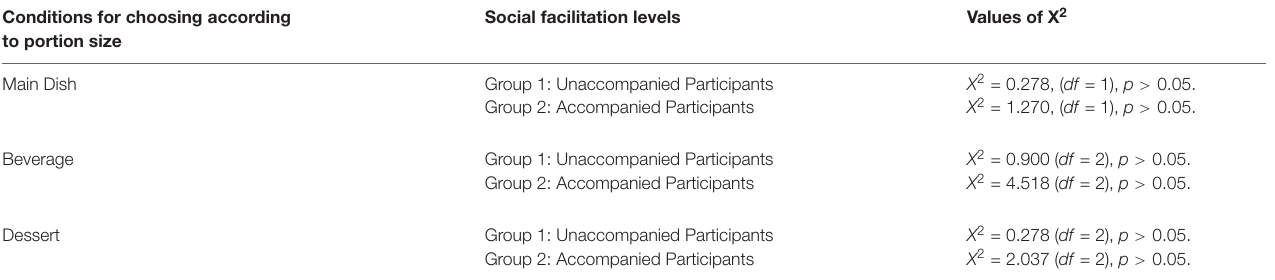
TABLE 4 | Chi-square results of main course, beverage, and dessert selection in session 4. Conditions for choosing according to portion